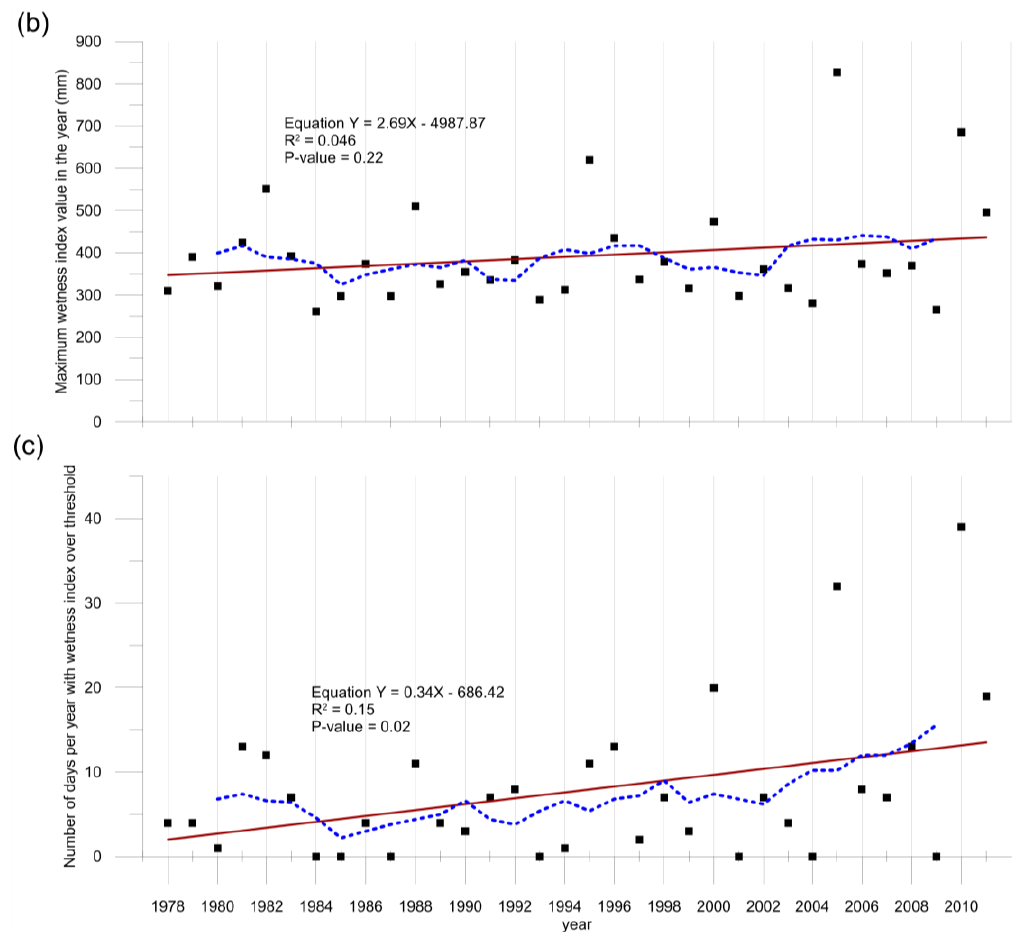
Figure 4. Precipitation trends 1978–2011, Retalhuleu station, Guatemala. Three approaches identifying trends in extreme precipitation: ( a ) yearly maxima of daily precipitation, ( b ) yearly maxima of 10-day period wetness index according to Soto et al. [32], ( c ) and yearly frequency of days when the 10-day period wetness index was equal to or higher than the aforementioned threshold. Data source: